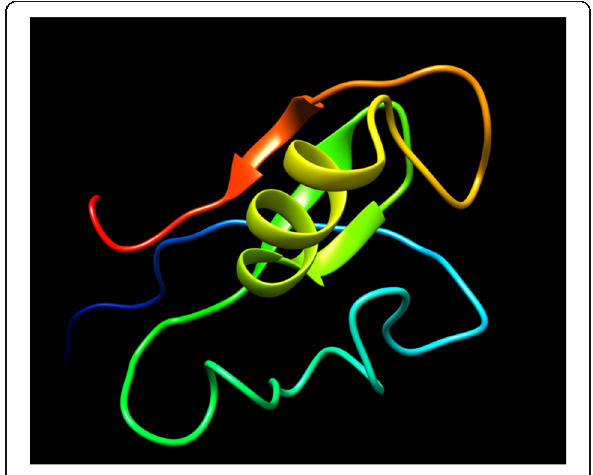
Fig. 3 Modelled tertiary structure of EhApc11 protein. The structure prediction was done by MODELLER. Chimera was used for model